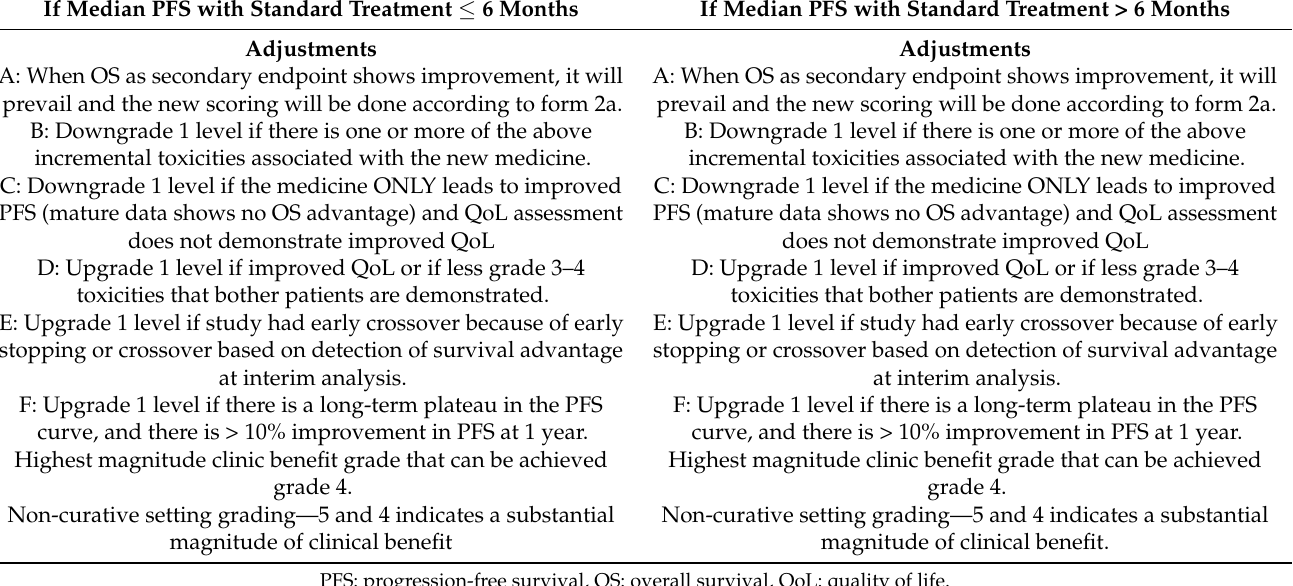
Table 4. ESMO-MCBS v1.1 evaluation form 2c. For therapies that are not likely to be curative with